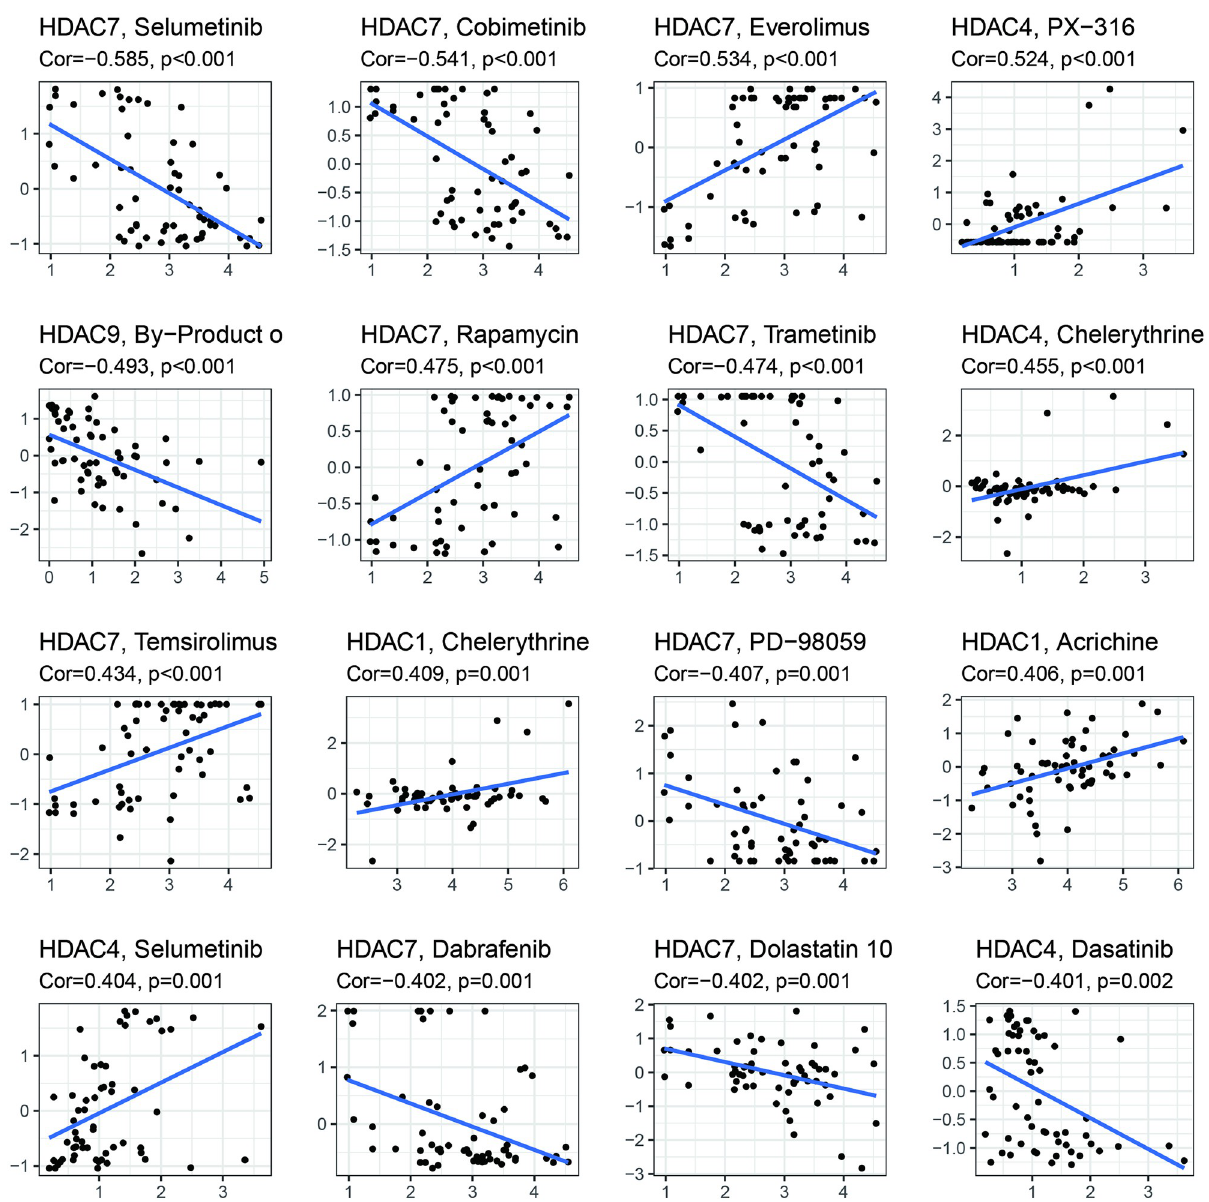
Fig 9. Chemotherapy sensitivity analysis for signature genes: HDAC1, HDAC4, HDAC5, HDAC7, HDAC9, HDAC10.